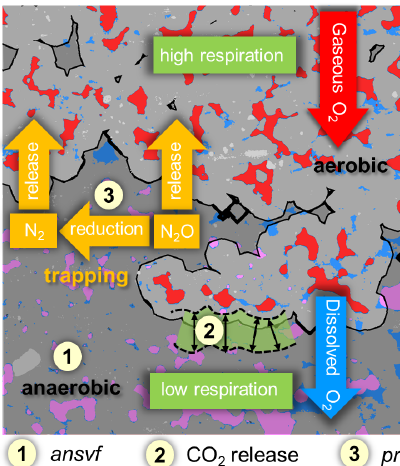
Figure 7. Explained variability expressed as R 2 with a confi- dence interval of 95% resulting from partial least square regres- sion (PLSR) with leave-one-out cross-validation and bootstrapping for response variables N 2 O (green symbols) or (N 2 O + N 2 ) fluxes (violet symbols) for pooled data of both soils (from Rotthalmün- ster (RM) and Gießen (GI)), WFPS treatments, and aggregate sizes ( n = 36). The yellow area shows a complex model including all explanatory variables of the present study (CO 2 , O 2 , connected- air content ( ε con ), diffusivity ( D sim ), anaerobic soil volume frac- tion (ansvf), and product ratio (pr) [N 2 O / (N 2 O + N 2 )]) (all) and a simplified model including only the most important predictors (CO 2 + ansvf ( + pr); predictor ( + pr) was only used for N 2 O emis- sions). The blue area shows additional simplified models with sub- stitutions of the most important predictor for O 2 supply (ansvf) by D sim or diffusivity calculated from an empirical model ( D emp ) (Deepagoda et al., 2011) or theoretical air content ( ε t ). The red area shows a simplified model with substitutions of the most important predictor for O 2 demand (CO 2 ) by soil organic matter (SOM; mea- sured in bulk soil). Substitution of the two most important predictors (CO 2 and ansvf) by SOM and D emp is shown in the violet area.